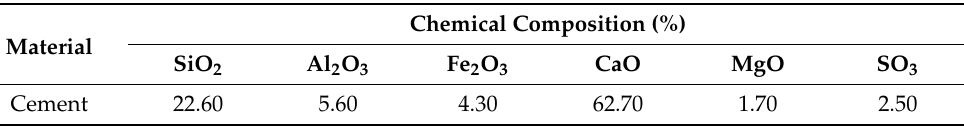
Table 1. The chemical composition of cement.